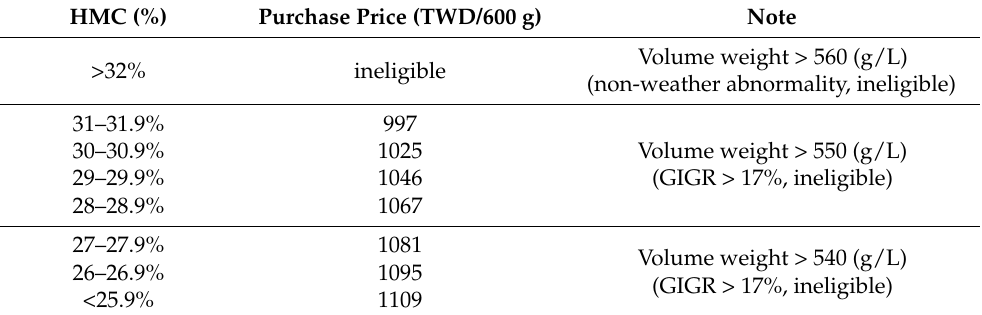
Table 1. Price reference of public stockholding programs by WuFeng Farmers’